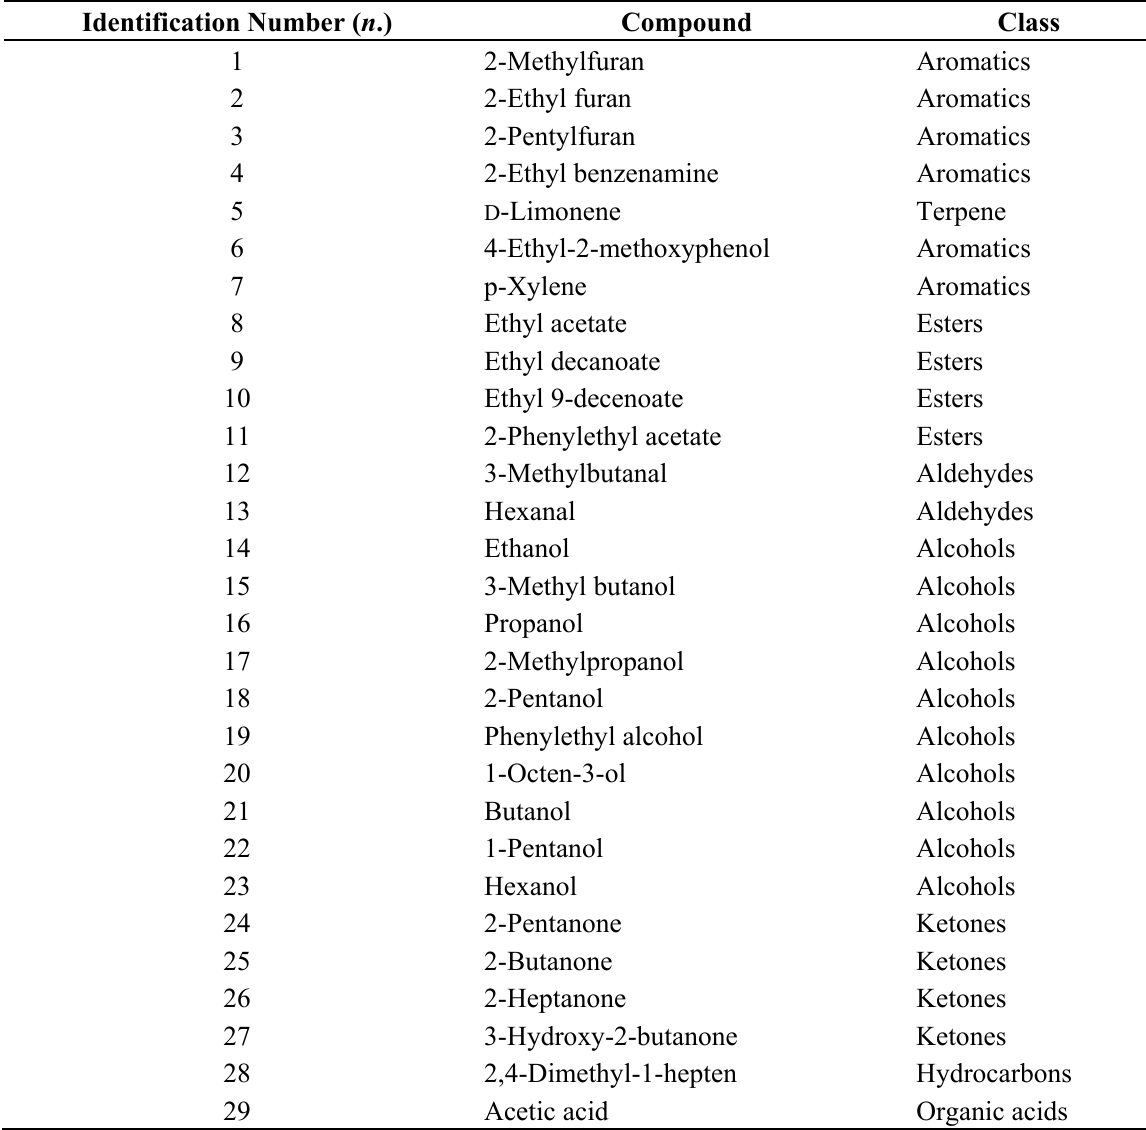
Table 1. GC-MS identification of volatile compounds in the headspace of durum wheat grains in the presence and absence of F. poae over seven days. Identification Number ( n